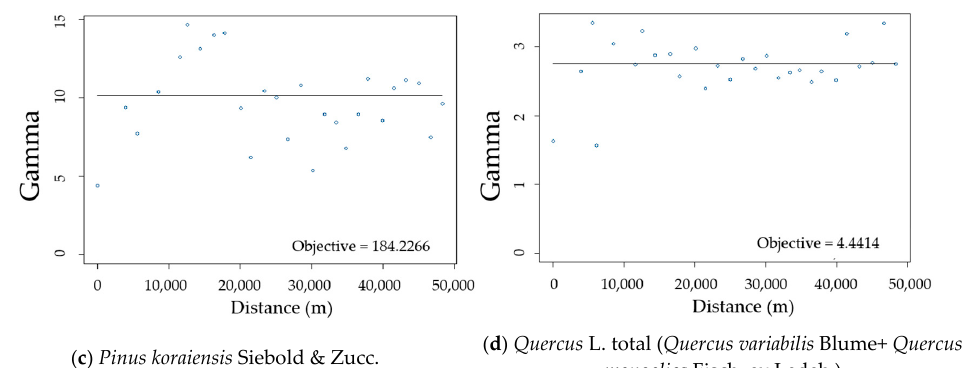
Figure 8. Semi-variogram analysis for each species by using an integrated model (non-spatial model + spatial model).